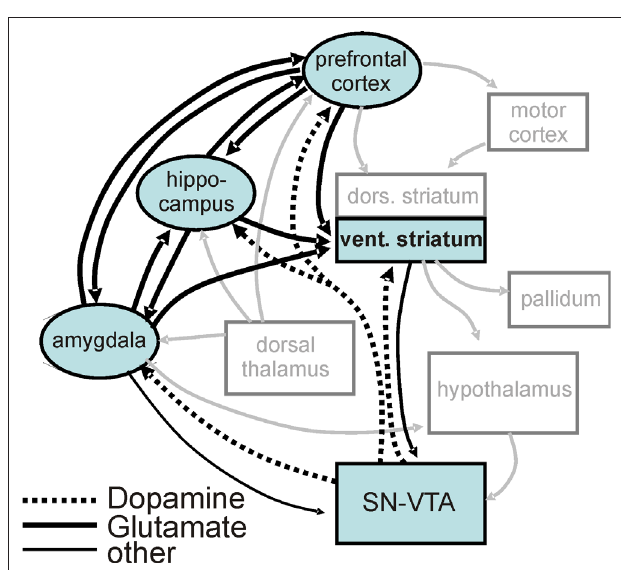
FIGURE 7 | Reward processing network in light of the current results. Illustration of the reward processing network revealed by the current connectivity analysis (black boxes, black arrows) embedded in a wider motivation/learning network (gray boxes and arrows). The wider network is slightly modifi ed (omitting unspecifi c hypothalamic/thalamic projections) from Kelley (2004).